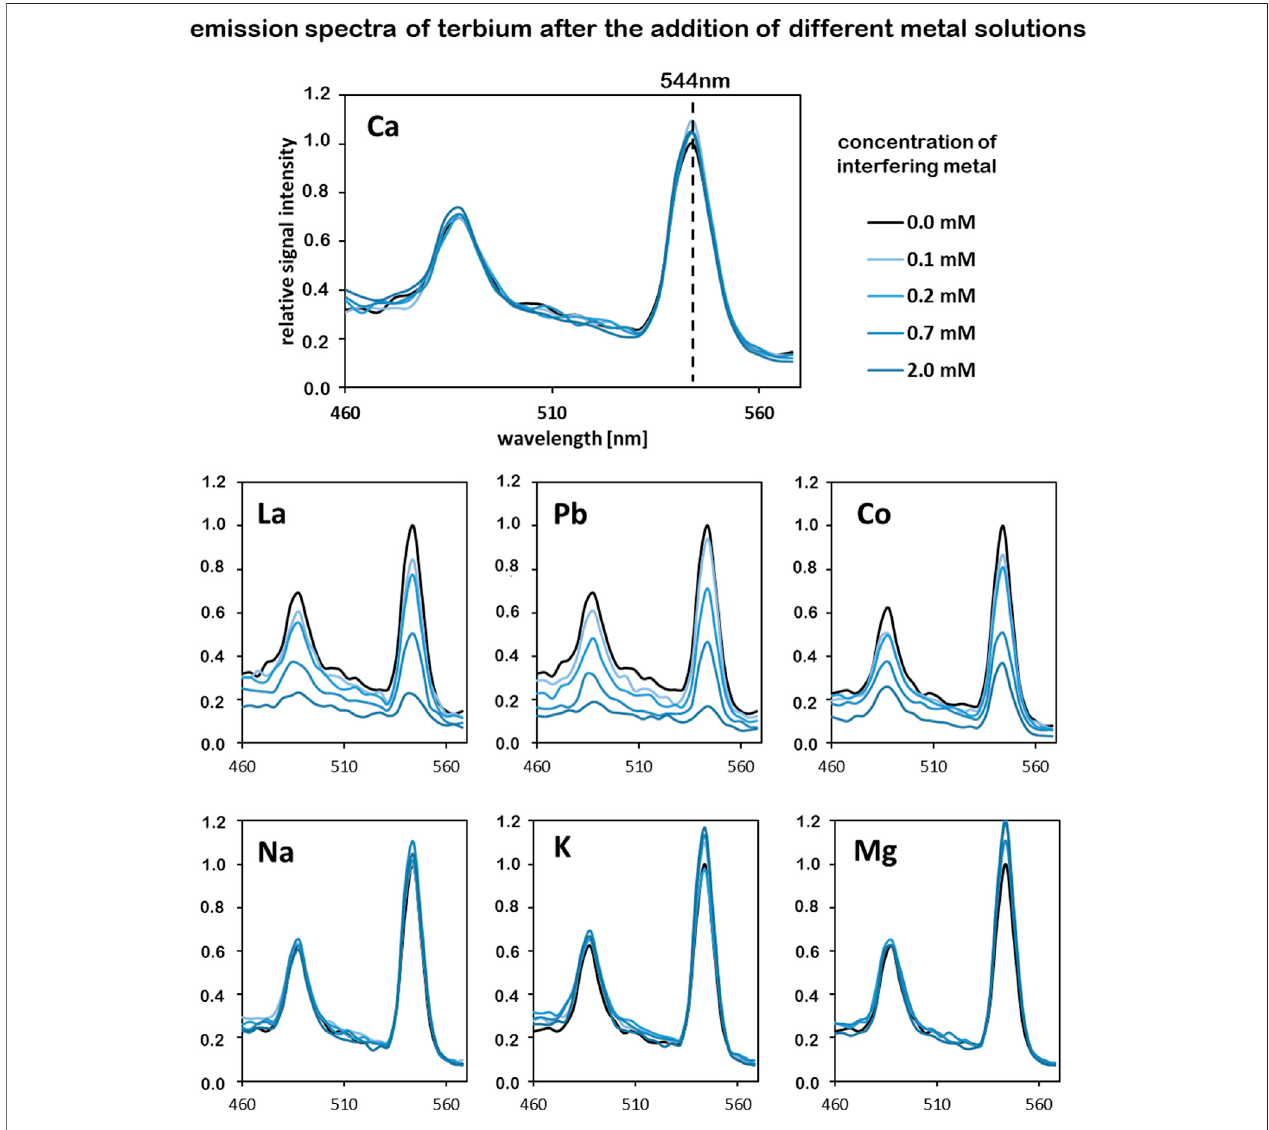
FIGURE 9 | Competition of different metals for complex formation with the isolated chelators ( < 10 kDa), tracked by analyzing the emission intensity of terbium; Tb concentration in all samples is 0.2 mM. Interfering metals were added in concentrations between 0.1 and 2.0 mM, excitation wavelength was set to 230 nm.